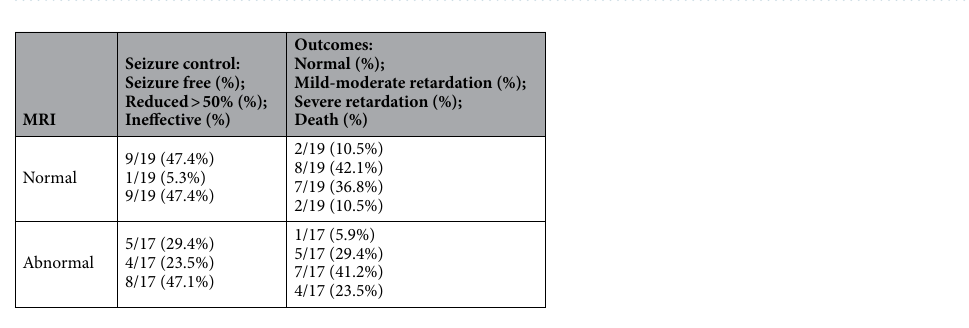
Figure 1. Migrating focal seizures was evident in the EEG data of the patient with PRRT2 gene mutation. ( A ) Interictal period showed multifocal discharge; ( B1 ) Focal seizures originating in the right occipital and posterior temporal regions; ( B2 ) More than 10 s later, the epileptiform electrical seizure in the right posterior occipital temporal region relieved, and electrical rhythm changes appeared in the right central region. ( B3 ) Convulsions of the left upper limb, simultaneous electrical seizures in the right central region; ( C1 ) Focal seizures originating in the right occipital and posterior temporal regions; ( C2 ) Focal seizures migrate to the left central region.